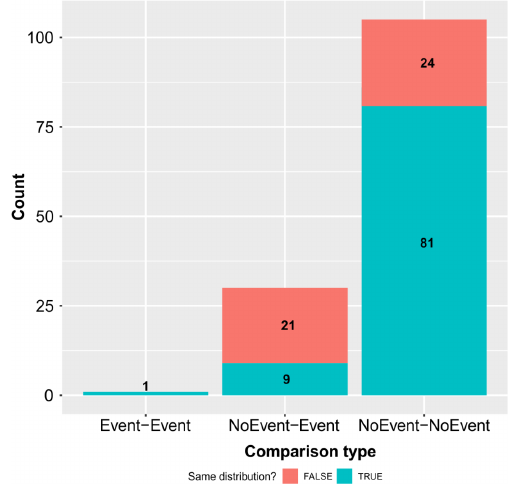
Figure 8. Histogram representing the differences between all the compared segment’s area distributions, calculated according to the p value of the Kolmogorov–Smirnov